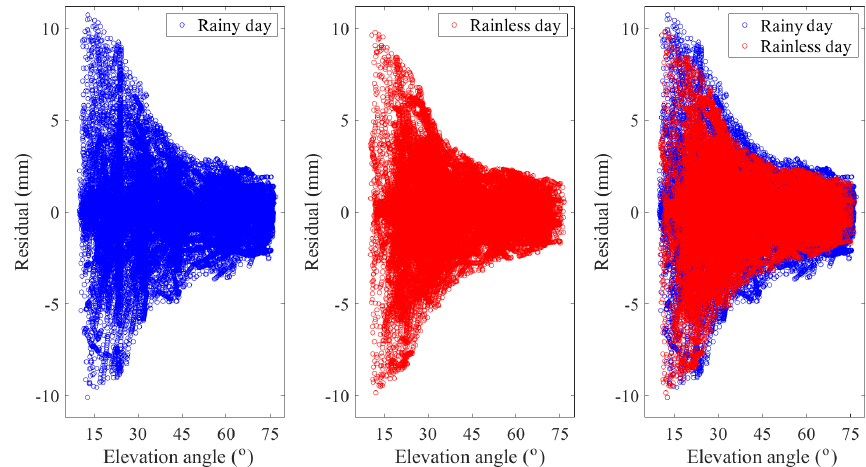
Figure 4. Scatter diagram of the SWV residuals in different weather conditions for internal accuracy testing.